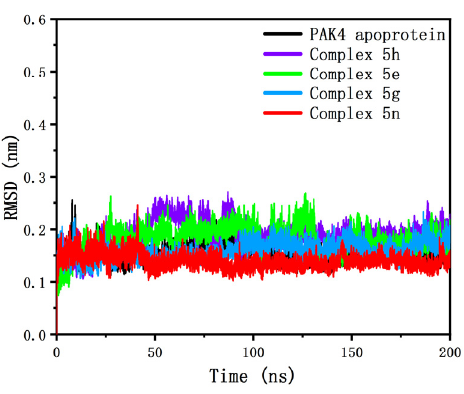
Figure 3. The RMSD of the C α atomic backbone of five systems as functions of time.